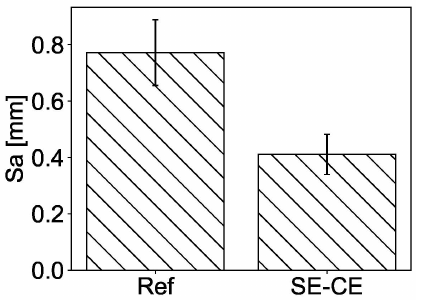
Figure 15. Surface roughness Sa for mixtures Ref and SE-CE.